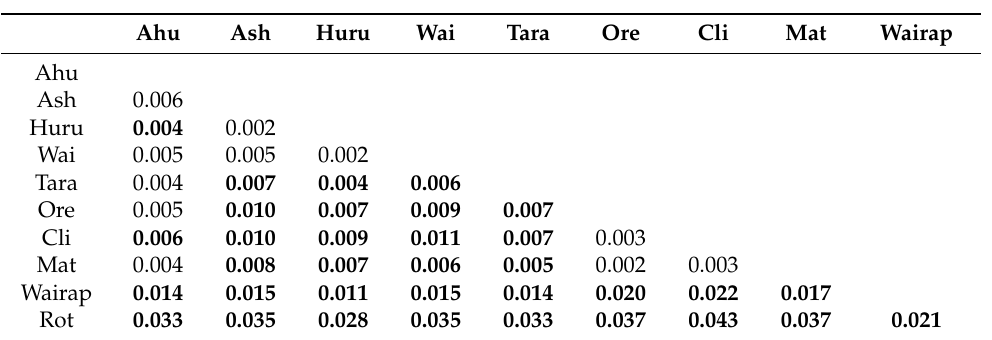
Table 3. Black-billed gull genetic differentiation matrix (F ST ) between catchments across New Zealand from SNPs. Bold indicates significant differences from 0 ( p < 0.05).